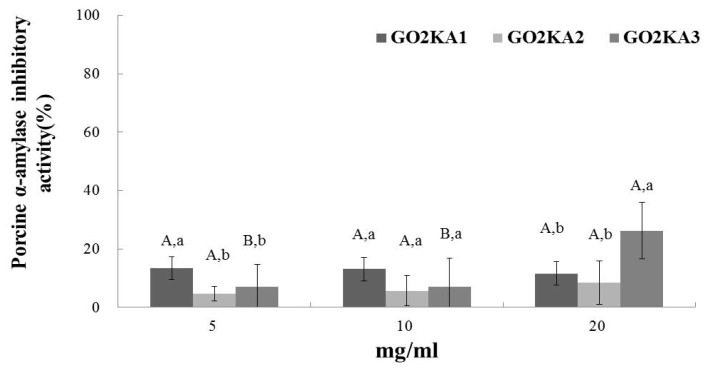
Dose dependent changes in porcine pancreas α-amylase inhibitory activity (% inhibition) of chitosan oligosaccharides classified by molecular weight (GO2KA1; MW < 1000 Da, GO2KA2; MW 1000–10,000 Da, GO2KA3; MW > 10,000 Da). The results represent the mean ± S.D. of values obtained from three measurements. Different corresponding letters indicate significant differences at p < 0.05 by Duncan’s test. A−C First letter is among different samples and a−c second one is among different concentrations within same samples.